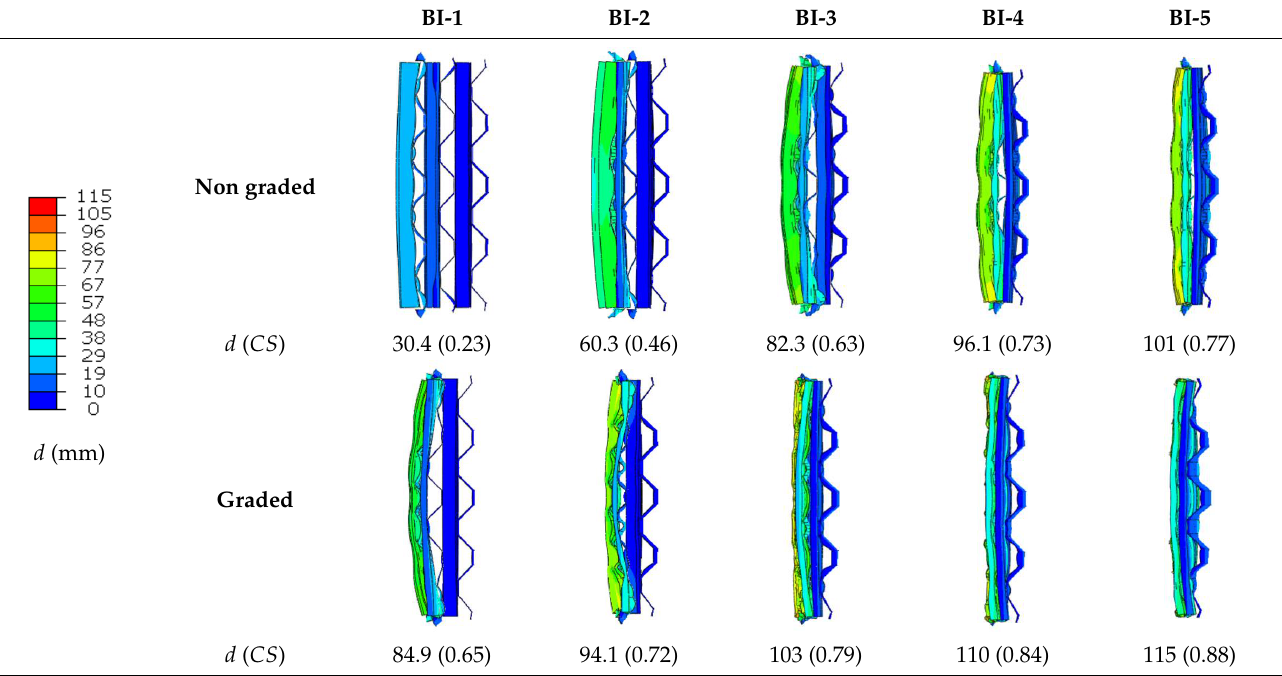
Table 6. Comparison between deformations 𝑑 (in mm) and compressive strains ( 𝐶𝑆 ) of the nongraded and graded trapezoidal cores when subjected to blast intensities BI-1 to BI-5.